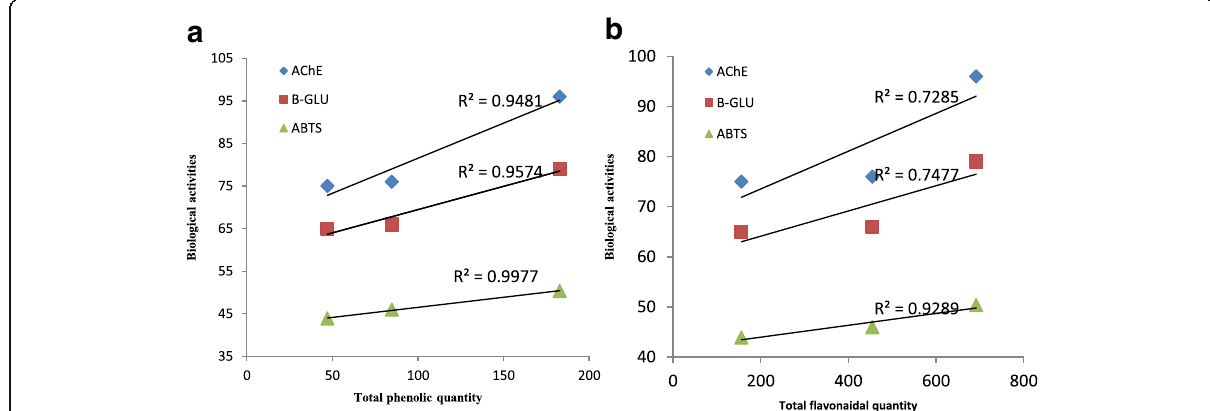
Fig. 5 Correlation coefficients (R 2 ) of TPC( a ) and TFC( b ) in the active fractions of title plants with their biological activities (AChE, β – Glu and